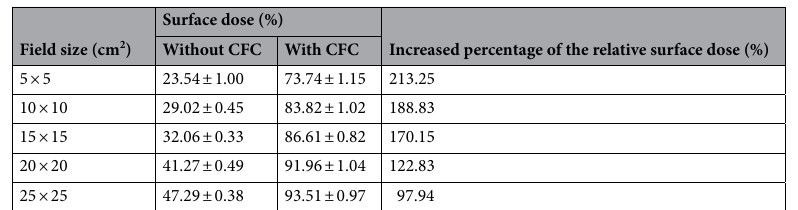
Table 1. Relative surface dose in various field sizes for 6 MV photon with and without carbon fiber couch (CFC).